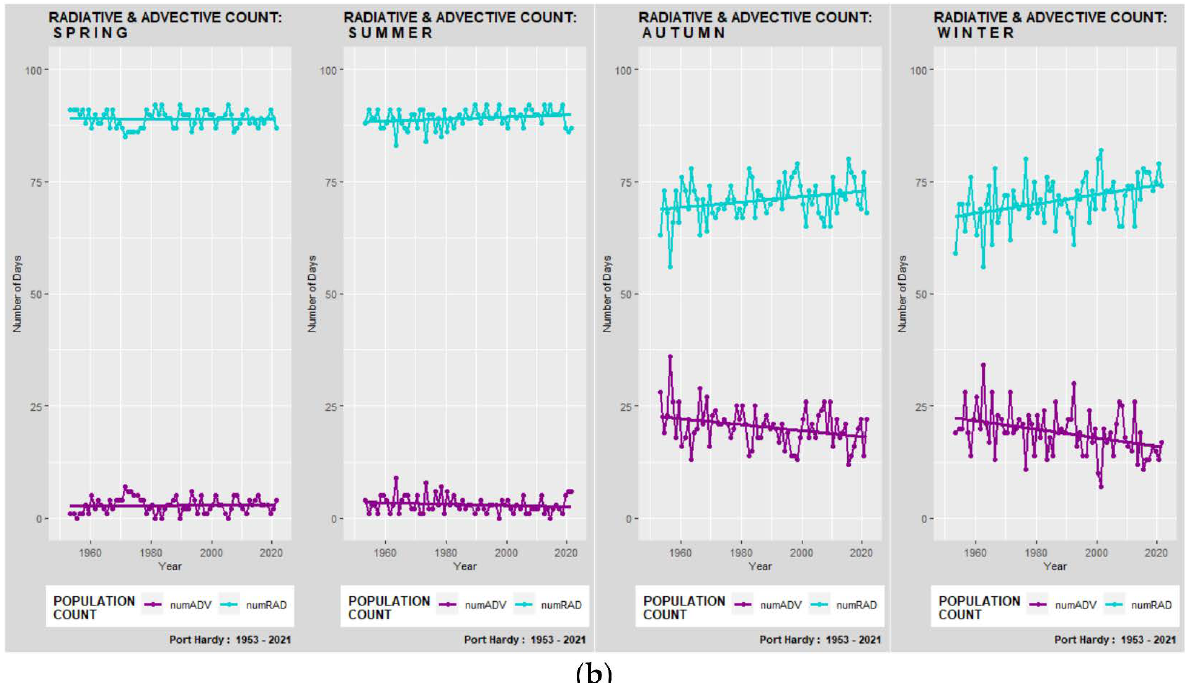
Figure 6. ( a )—South British Columbia Mountains (SBC); Abbotsford (BC), ( b )—Pacific Coast (PAC); Port Hardy (BC). Seasonally averaged radiative and advective temperature population counts, listed in order of Spring, Summer, Autumn, and Winter. ( a )—Radiative Population Count ( RPC ) (cyan blue), and Advective Population Count ( APC )